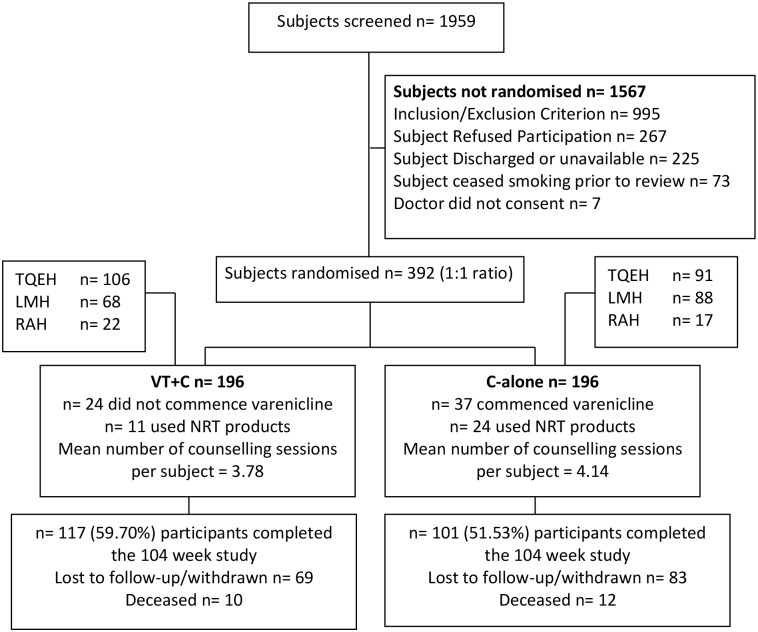
Participant disposition (Consort flow diagram).